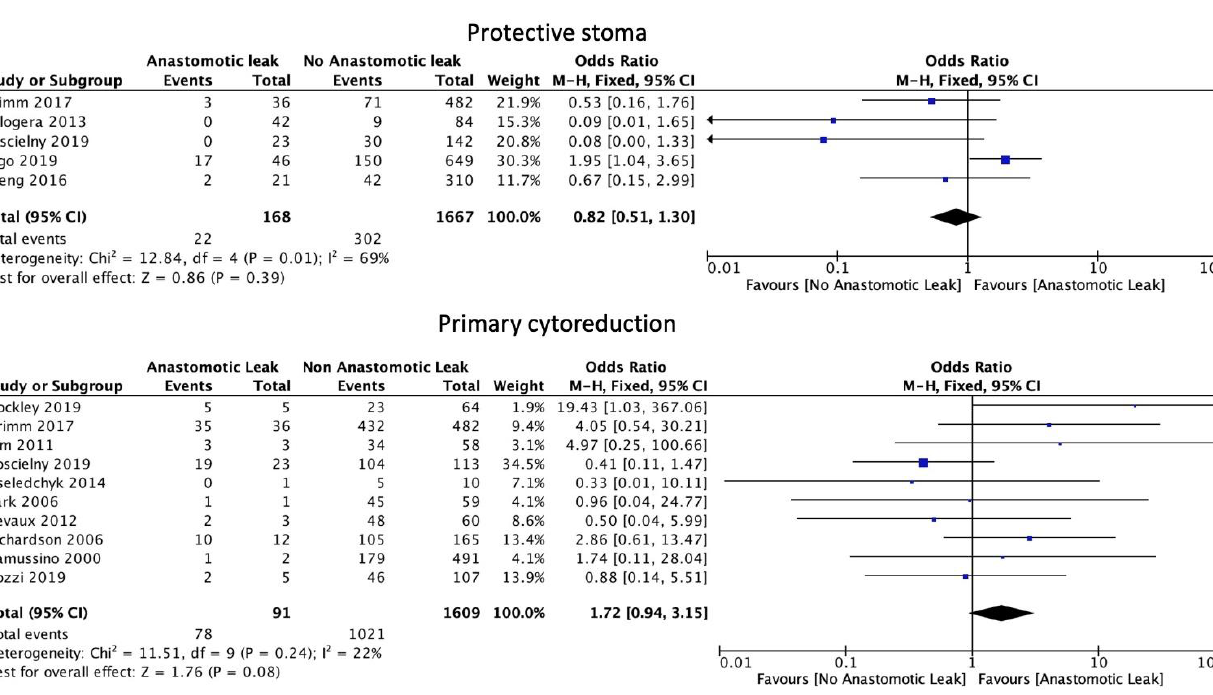
Figure 5. Intraoperative outcomes.